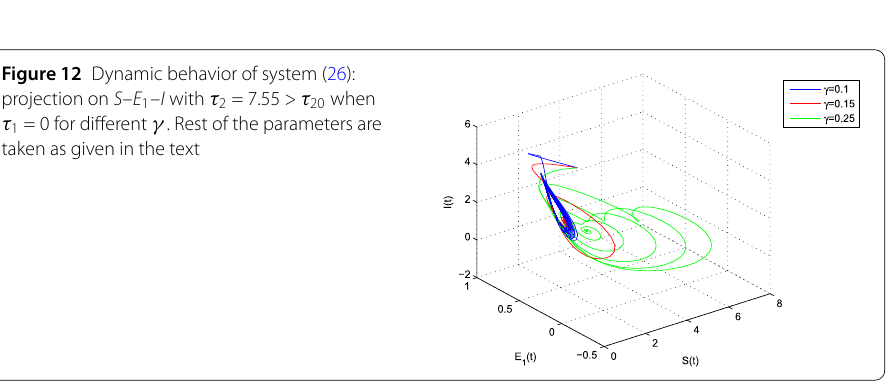
Figure 11 Time plots of S , E 1 , E 2 and I for different γ at τ 2 = 6.25 when τ 1 = 0. Rest of the parameters are taken as given in the text